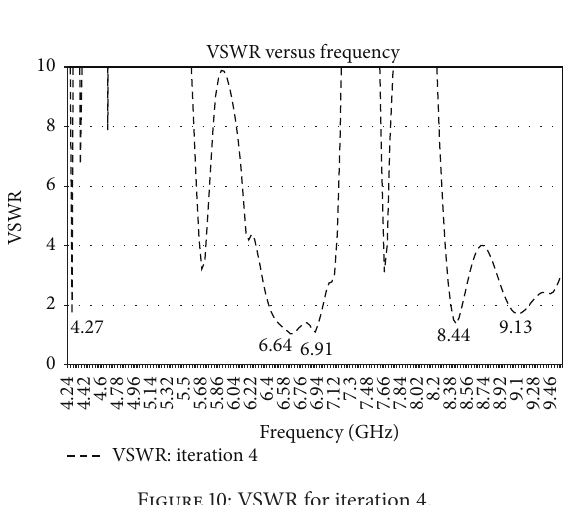
Figure 10: VSWR for iteration 4.